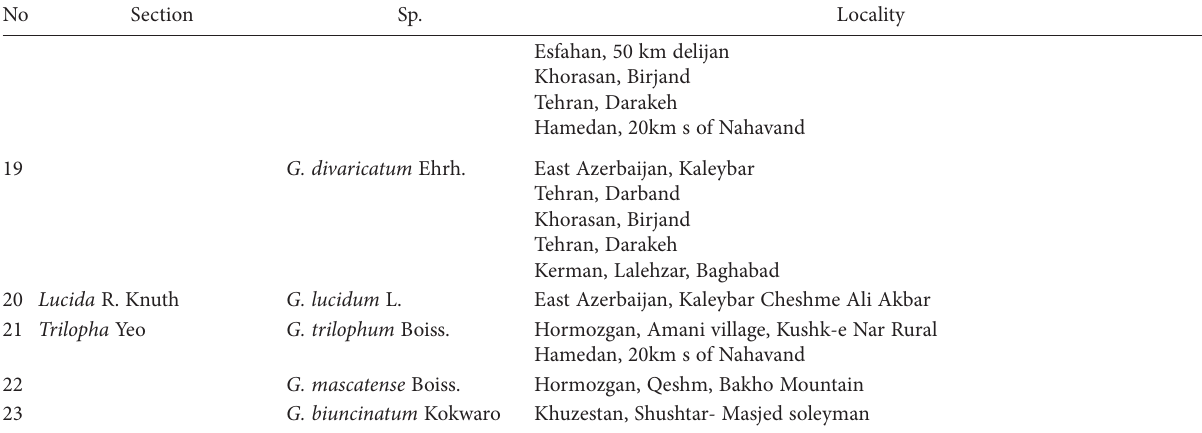
Table. 2. Evaluated characters of pollen grains in Geranium species studied (values M ± SD μm). M- Mean value; SD- Standard deviation. Aperture: At the same level =2, protruding = 1; Pollen shape: prolate-spheroidal =1, spheroidal= 2, subprolate=3; Exine ornamentation type: reticulate-clavate=1, striate-rugulose =2, reticulum cristatum with clavae= 3